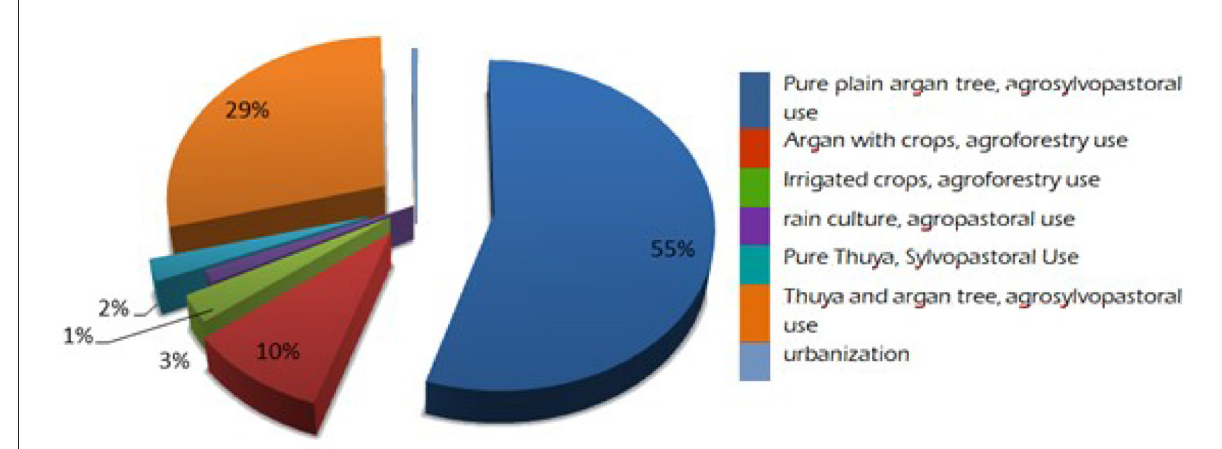
FIGURE10 Contribution (percent) of different LUS in Amskroud commune area.